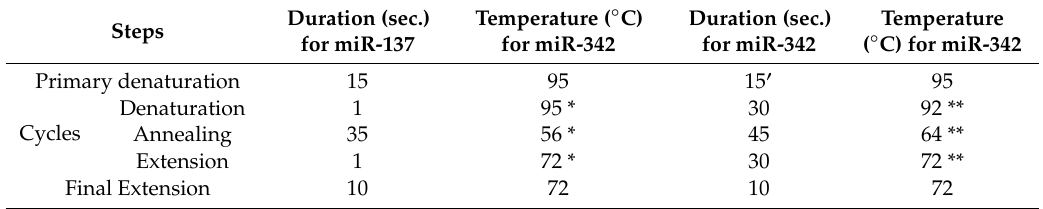
Table 2. Thermocycler-optimized PCR program for miR-137 and miR-342 genes.